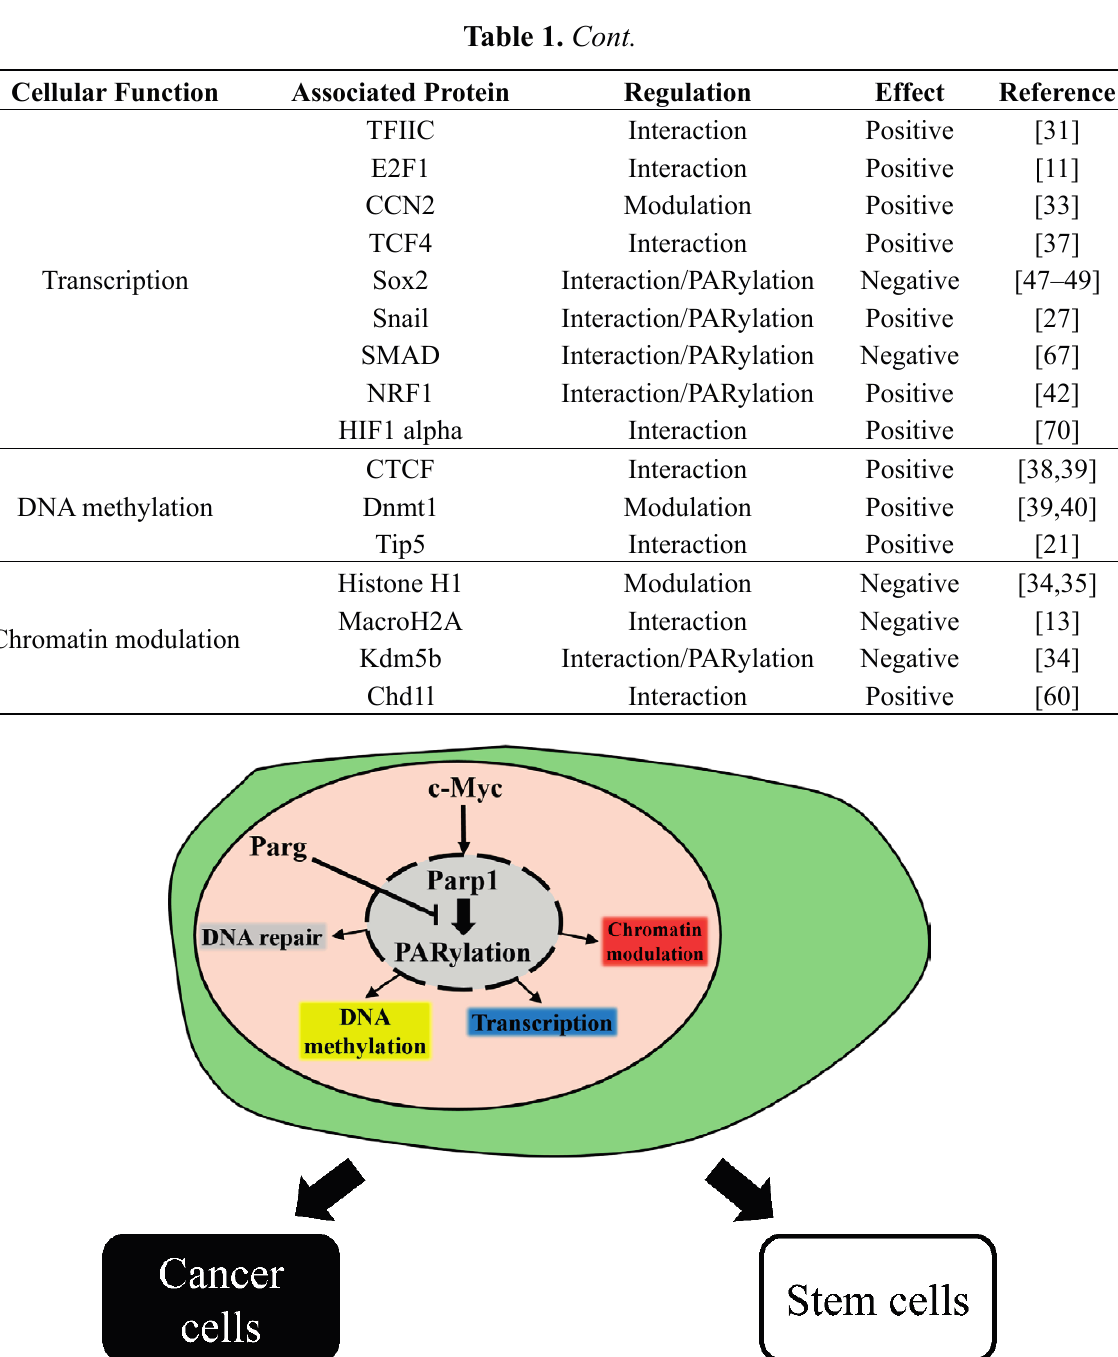
Figure 1. Intracellular regulations of Parp1. Parp1 is activated by c-Myc, Parp1 regulates cellular functions including DNA repair, transcription, DNA methylation, and chromatin modulation through PARylation of downstream proteins or directed binding to target protein. Poly(ADP-ribose) glycohydrolase (Parg) degrades the PAR chains of target protein to dismiss the downstream signaling. Precise regulation of the balance between PARylation and dePARylation is imperative to determine the cell fate of cells toward stem cell or cancer